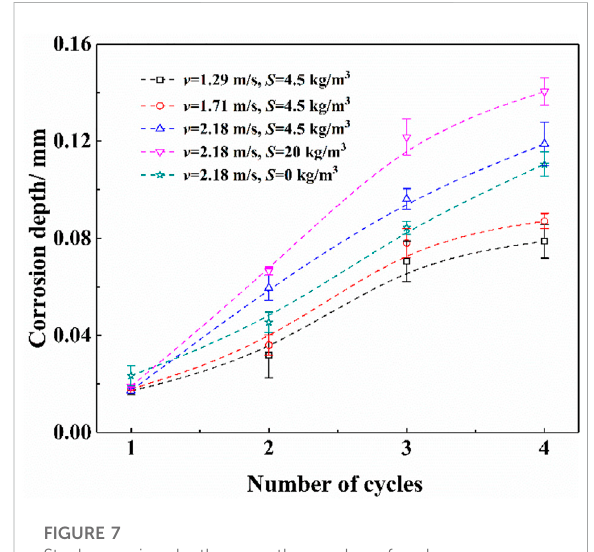
FIGURE 7 Steel corrosion depth versus the number of